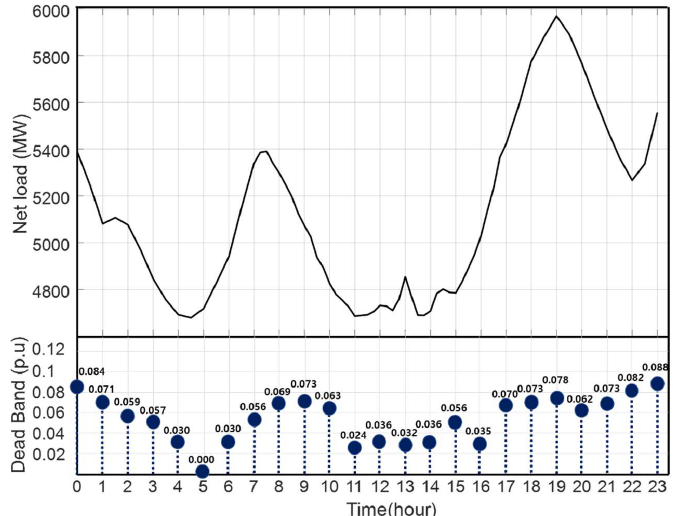
Figure 14. Net load curve and dead band result by time.